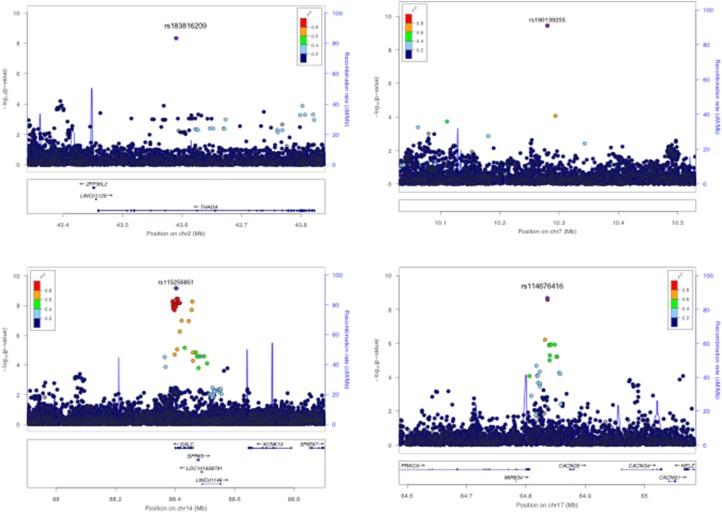
Regional association plots for VCA serostatus genome-wide significant associations, N = 1562, seropositive = 1344, seronegative = 217, threshold = p < 5 × 10−9. (a) Genome-wide significant association rs183816209 on Chromosome 2 in the THADA region (p = 4.5 × 10−9). (b) Genome-wide significant rs190139255 association on Chromosome 7 (4.0 × 10−10). (c) Genome-wide significant association rs115256851 on Chromosome 14 in the GALC region (6.8 × 10−10). (d) Genome-wide significant association rs114576416 on Chromosome 17 in the CACNG5 region (2.2 × 10−9). The lead SNPs are labelled and coloured in purple. LD (r2) was calculated based on the Ugandan SNP genotypes used in this study.